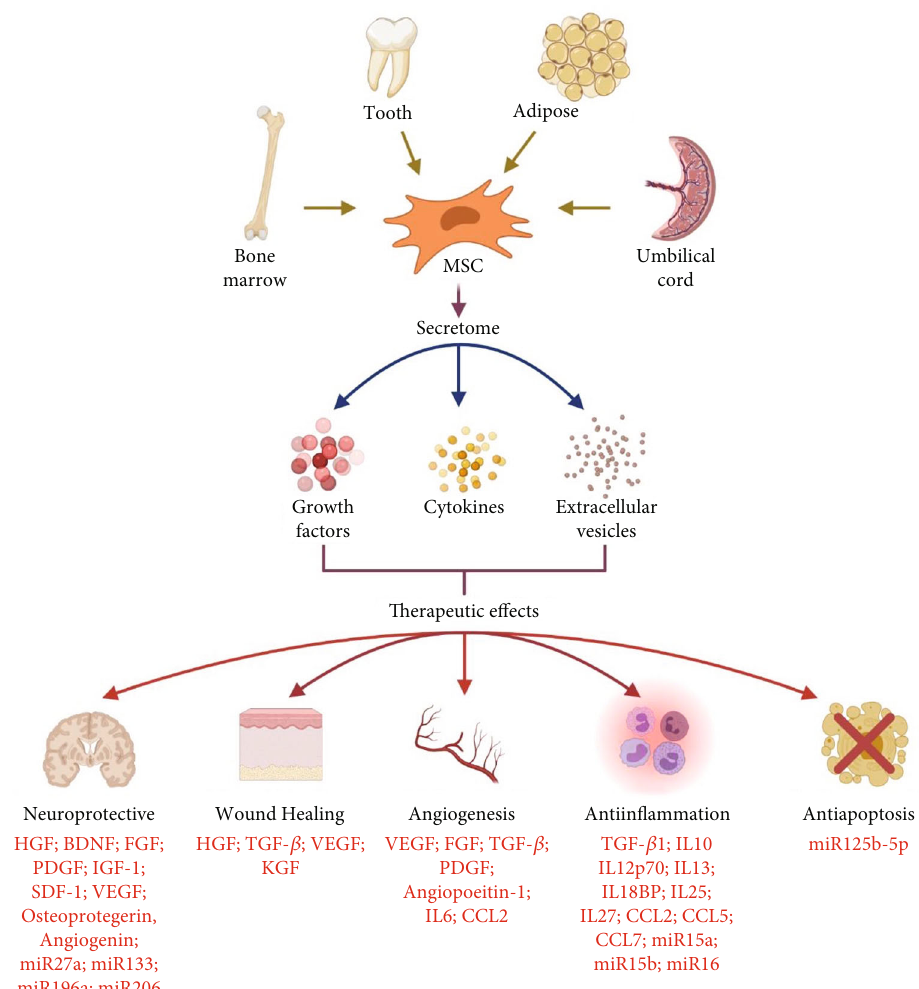
Figure 3: Mesenchymal stem cell sources, secretome content, and its therapeutic e ff ects. MSCs can be derived from various sources, including bone marrow, teeth (deciduous vs. nondeciduous), adipose tissue, and umbilical cord. MSCs mainly rely on the secretome, which consists of various soluble factors (growth factors and cytokines) and extracellular vesicles to exert their therapeutic e ff ects. Neuroprotection, acceleration of wound healing, induction of angiogenesis, suppressing of in fl ammation, and prevention of cell apoptosis are some of the reported therapeutic potentials of MSC secretome. HGF: hepatocyte growth factor; BDNF: brain-derived neurotrophic factor; FGF: fi broblast growth factor; PDGF: platelet-derived growth factor; IGF-1: insulin-like growth factor 1; SDF-1: stromal cell-derived factor 1; VEGF: vascular endothelial growth factor; TGF- β : transforming growth factor-beta; KGF: keratinocyte growth factor; IL: interleukin; miR: microRNA; CCL: C-C motif chemokine ligand (created with